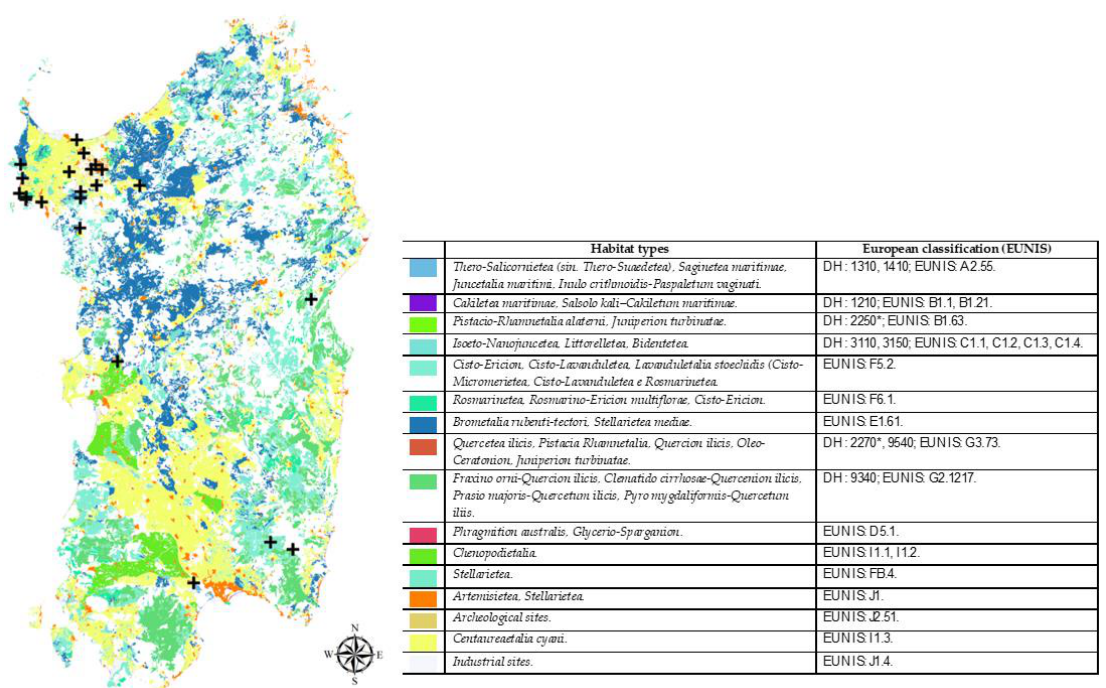
Figure 1. Position of Sardinia in the Mediterranean Basin and sampling sites (red dot) on the island.